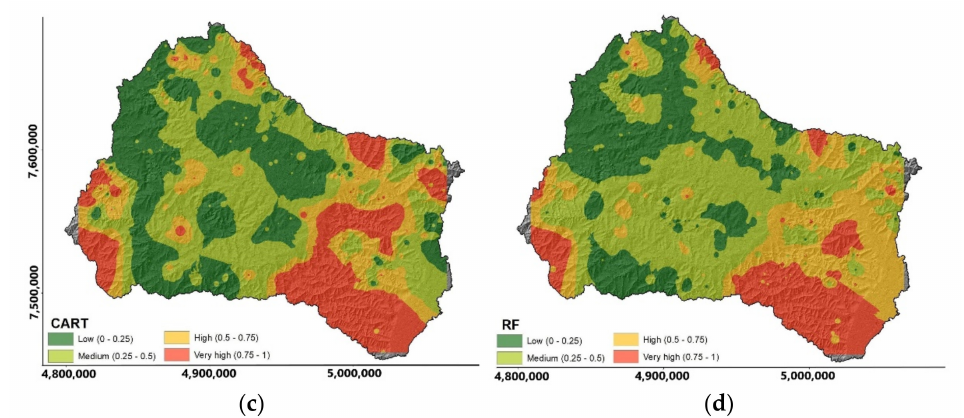
Figure 7. Gullying susceptibility distribution maps built from ( a ) multivariate discriminant analysis (MDA), ( b ) logistic regression (LR), ( c ) classification and regression tree (CART), and ( d ) random forest (RF). Spatial references SIRGAS_2000_Brazil_Polyconic in meters.